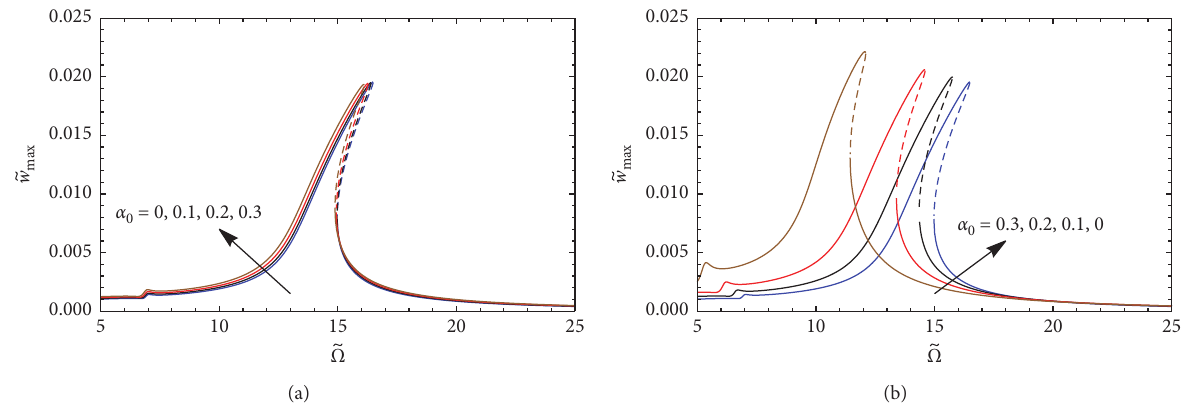
Figure 12: The influence of porosity on the frequency-response curves of transverse motion of SS BDFG beam when m and c d � c r � 0 . 05. (a) Nonuniform porosity (equation (3)). (b) Uniform porosity ( α ( x, y ) � α